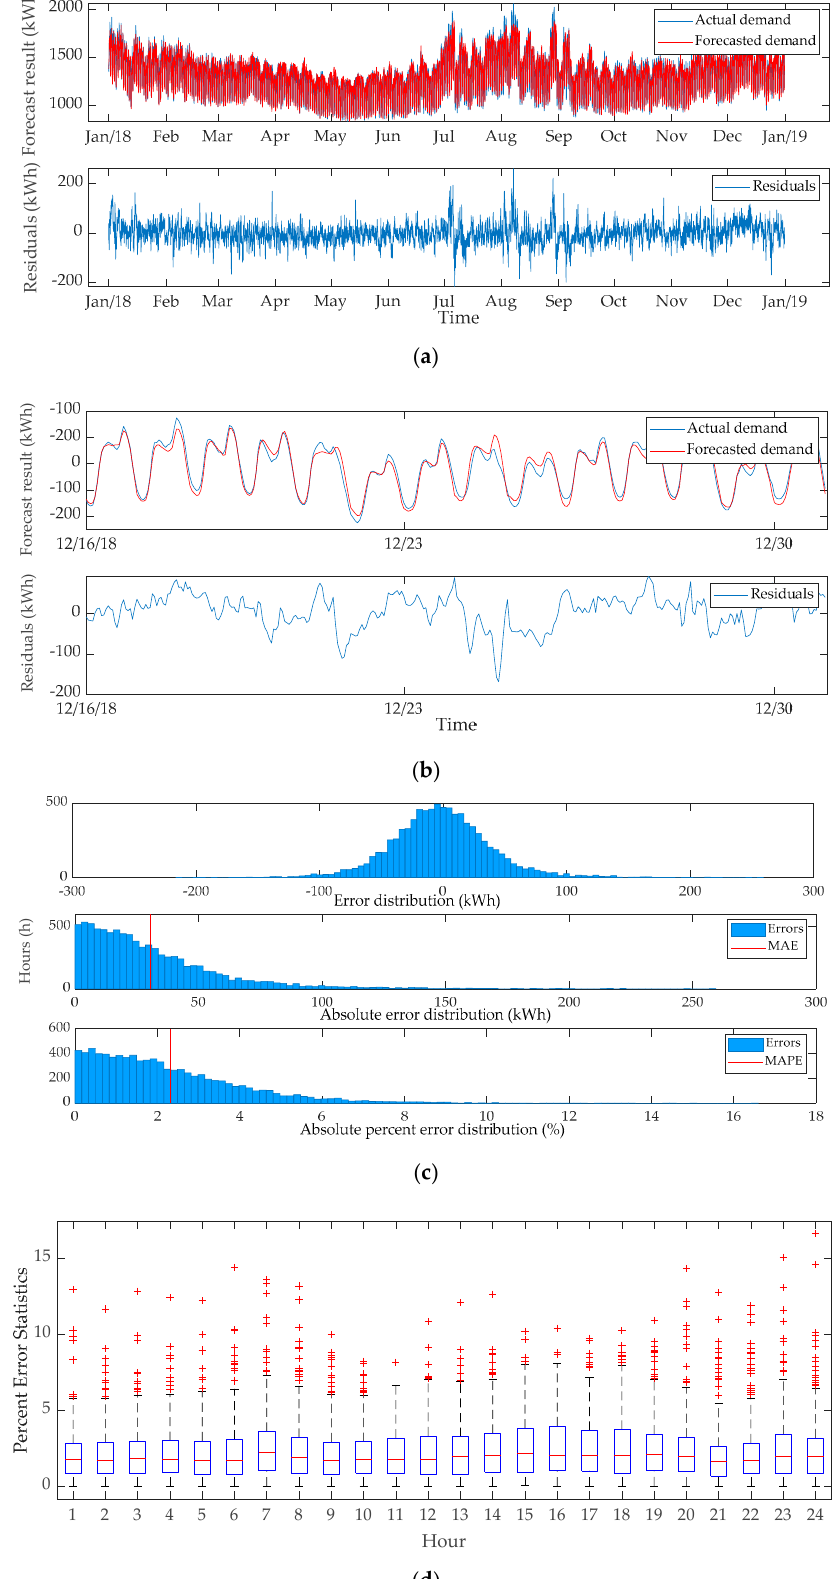
Figure 6. Hour-ahead demand forecast results by ANN. ( a ) Demand forecast results of a whole year; ( b ) Demand forecast results of two weeks; ( c ) Forecast error distribution; ( d ) Breakdown of forecast error statistics by hour.